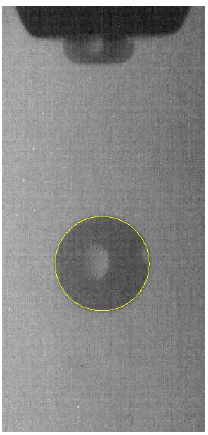
Figure 11. Circle fitting of the droplet profile (sub-pixel accuracy).